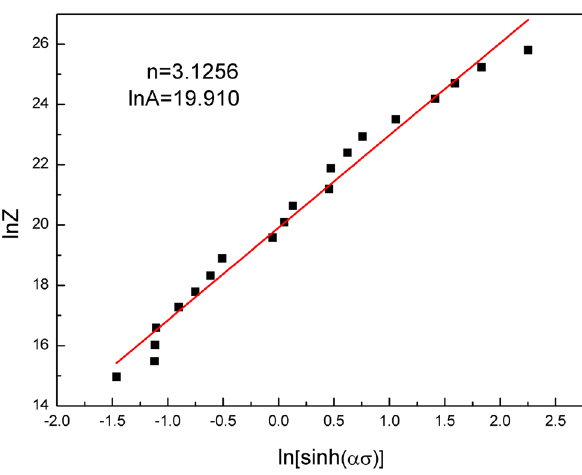
Figure 5: Linear regression analysis for the ln Z − ln [ sinh ( ασ )]